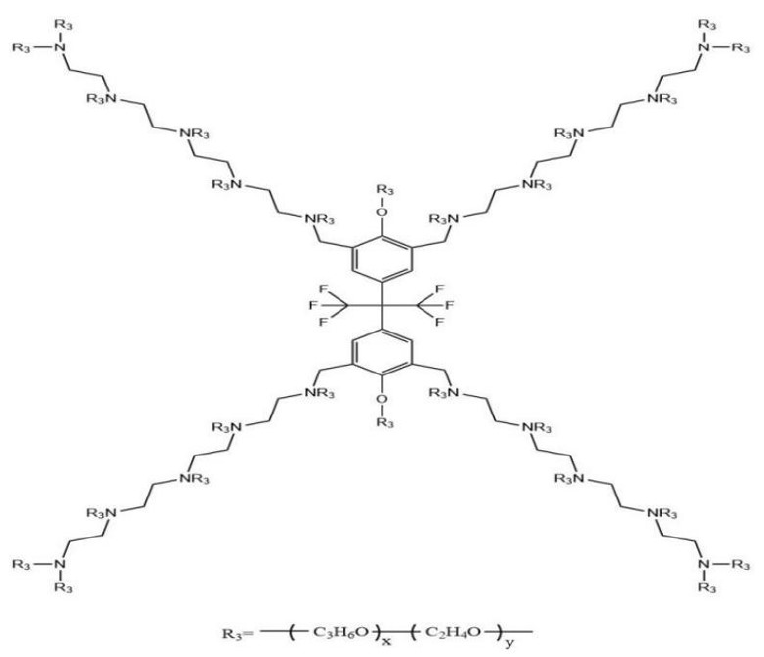
Figure 19. Molecular structure of fluorinated demulsifier.